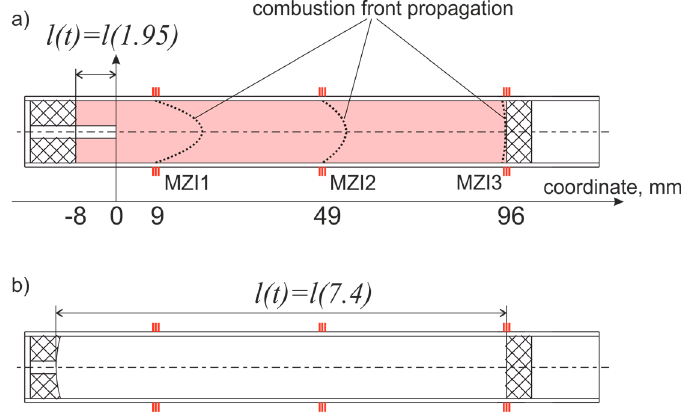
Figure 2. Combustion chamber scheme before ( a ) and after ( b ) work.